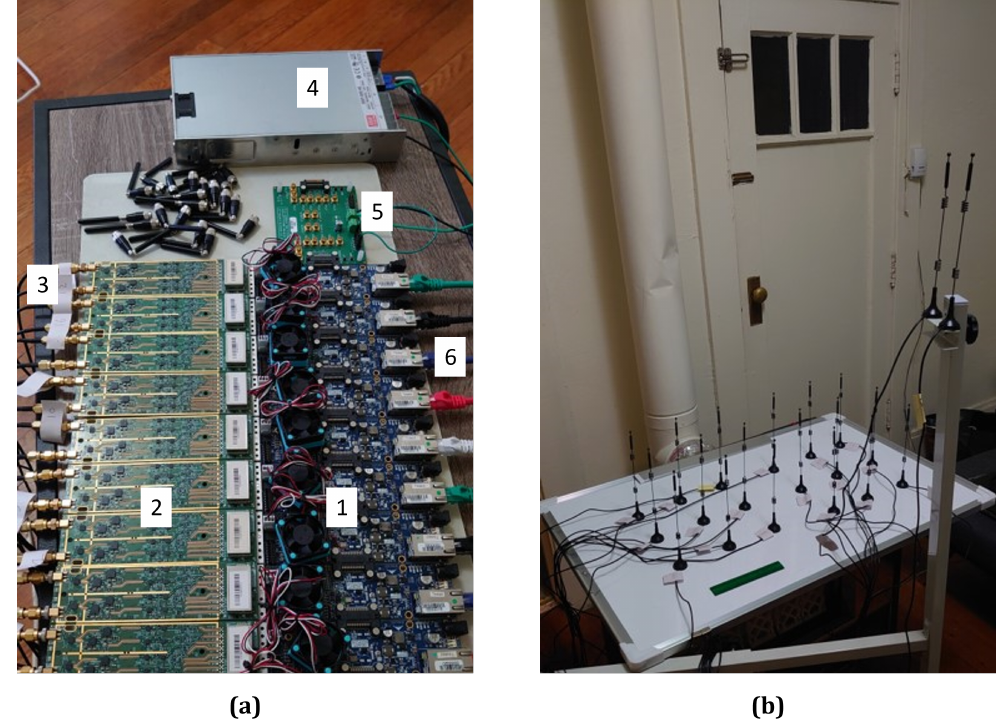
Figure 3. ( a ) Our radio hardware, including Skylark Wireless Iris radios (1) and associated RF front ends (2), antenna cable extensions (3), AC/DC power converter (4) and bus power converter (5), and ethernet connections (6). ( b ) An example antenna layout. In this picture, the antennas are not yet set in their exact test configuration.